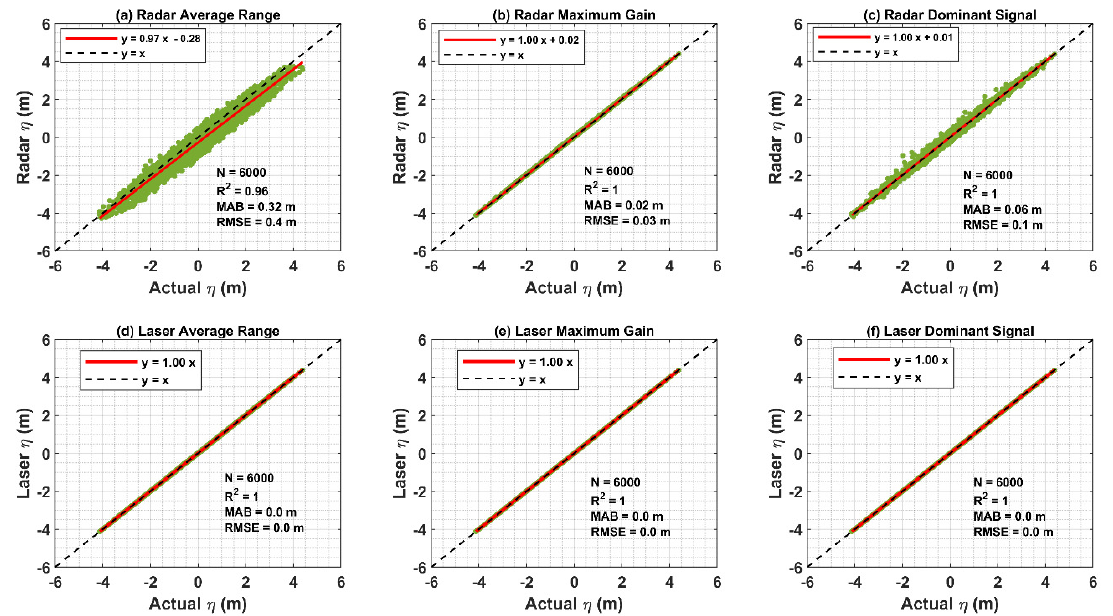
Figure 7. Comparisons of actual surface elevation with average range ( a , d ), maximum gain ( b , e ), and dominant signal ( c , f ) estimated from the Radar and Laser simulations for a swell dominating sea state with a significant wave height ( H m 0 ) and peak frequency ( f P ) of 5.8 m and 0.07 Hz, respectively.